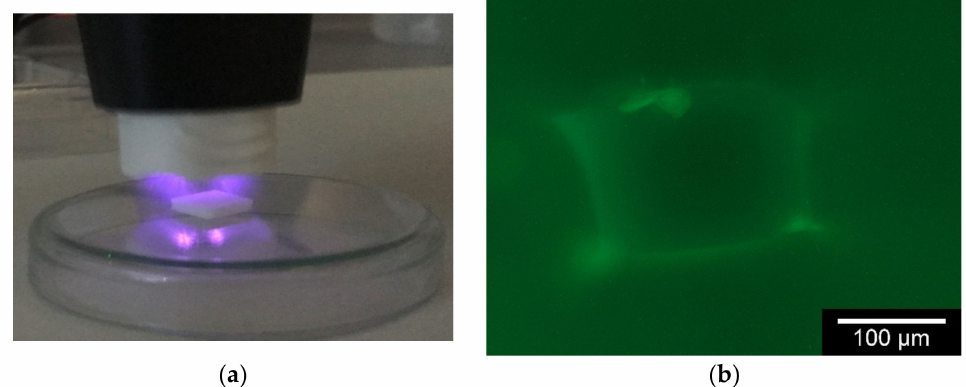
Figure A1. Additional Images: ( a ): Plasma treatment with Relyon Piezobrush PZ3; ( b ): fluores- cence image of immunoassay on a different position of the scaffold, image taken with fluorescence microscope Olympus BX-53, 100 ms exposure